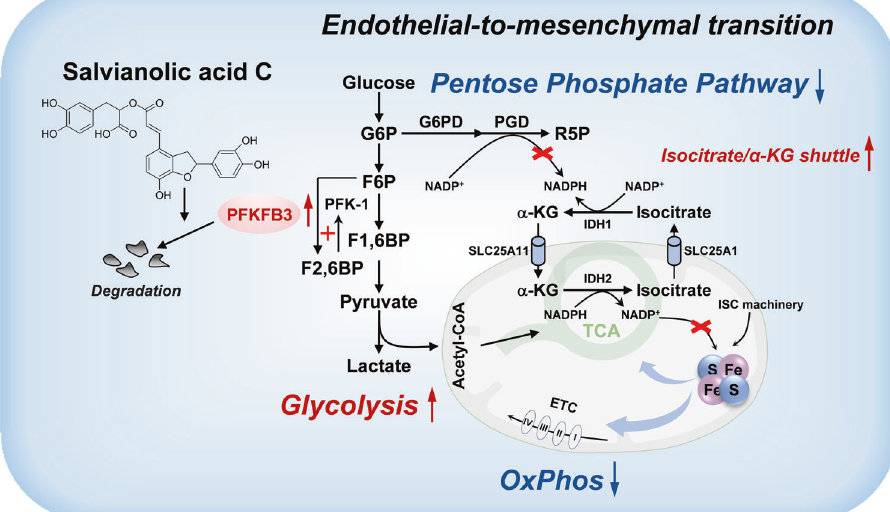
Fig. 9 Schematic depicting the molecular mechanism through which SAC restrains EndoMT via suppression of PFKFB3. EndoMT is characterized by increased expression of PFKFB3 that drives abnormal glycolysis and hijacks glucose fl ux from pentose phosphate pathway (PPP) to compromise cytoplasmic NADPH production. Ef fl ux of mitochondrial NADPH through isocitrate/ α -KG shuttle replenishes cytoplasmic NADPH pool but meanwhile impairs mitochondrial respiration by hampering mitochondrial Fe-S cluster protein biosynthesis. SAC disrupts PFKFB3 stability by accelerating its degradation and thus maintains endothelial metabolic homeostasis, underlying its anti-EndoMT